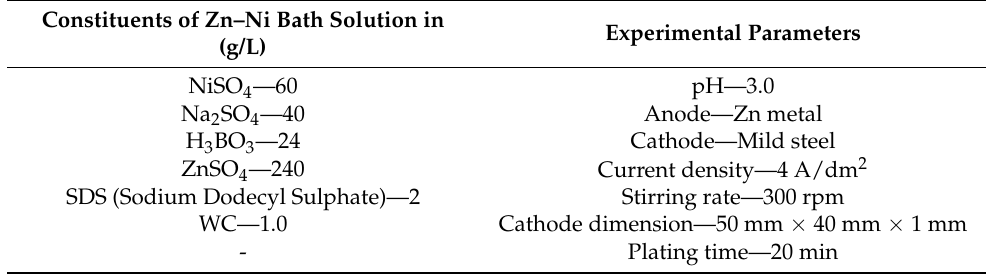
Table 1. Electrolytic solution composition. Constituents of Zn–Ni Bath Solution